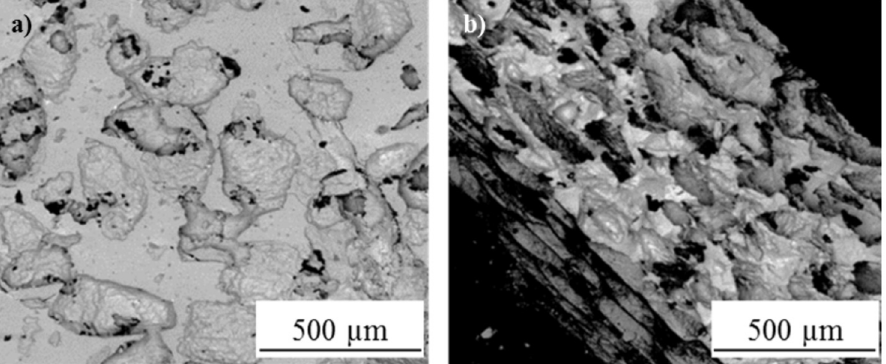
Figure 8. Adapted with permission from C. Domínguez-Trujillo et al. [28]. Copyright 2018 Elsevier. License number 5318790646724. SEM micrographs of the HAp coatings on porous titanium substrates. ( a ) Plain view, ( b ) cross-section.